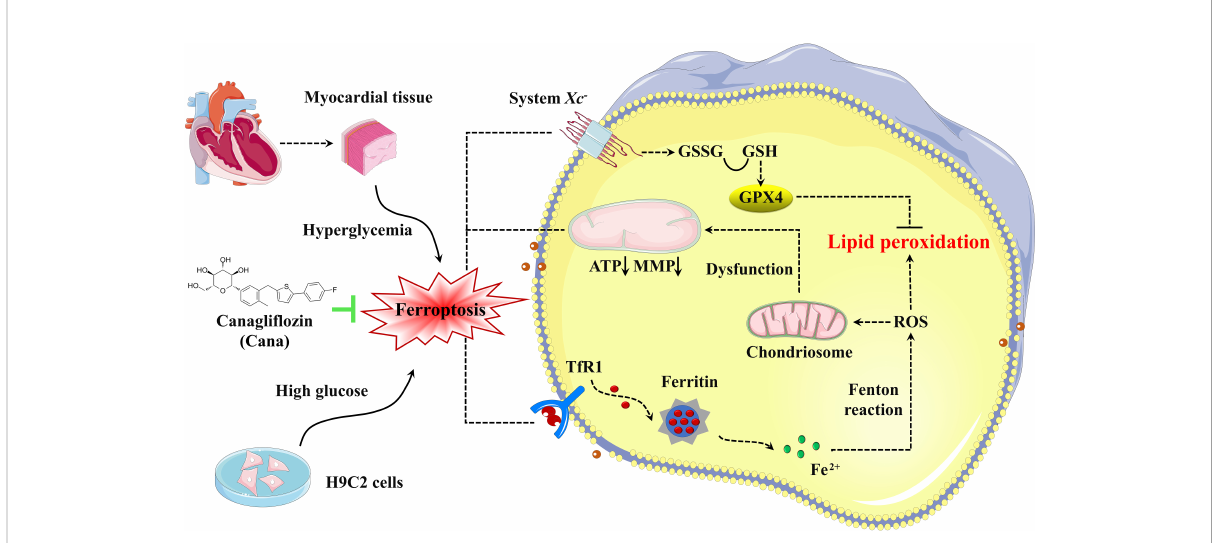
FIGURE 6 Schematic illustration of Cana alleviating ferroptosis in diabetic cardiomyopathy. High glucose, as pivotal pathogenic factors of DCM, inhibit the expression of SLC7A11 and promote the expression of TfR1, which in turn decrease the GSH levels and increase the labile iron levels, respectively. These alterations lead to increased lipid peroxidation and cardiomyocyte ferroptosis, which then initiates cardiac dysfunction, eventually leads to the DCM. Cana promotes upregulation of SLC7A11 and downregulation of TfR1 and FTN-H, which protect the cardiomyocytes from ferroptosis. TfR1, transferrin receptor 1; ROS, Reactive Oxygen Species; GSSG, oxidized glutathione; GSH, glutathione; GPX4, glutathione peroxidase 4; MMP, mitochondrial membrane potential; ATP, adenosine